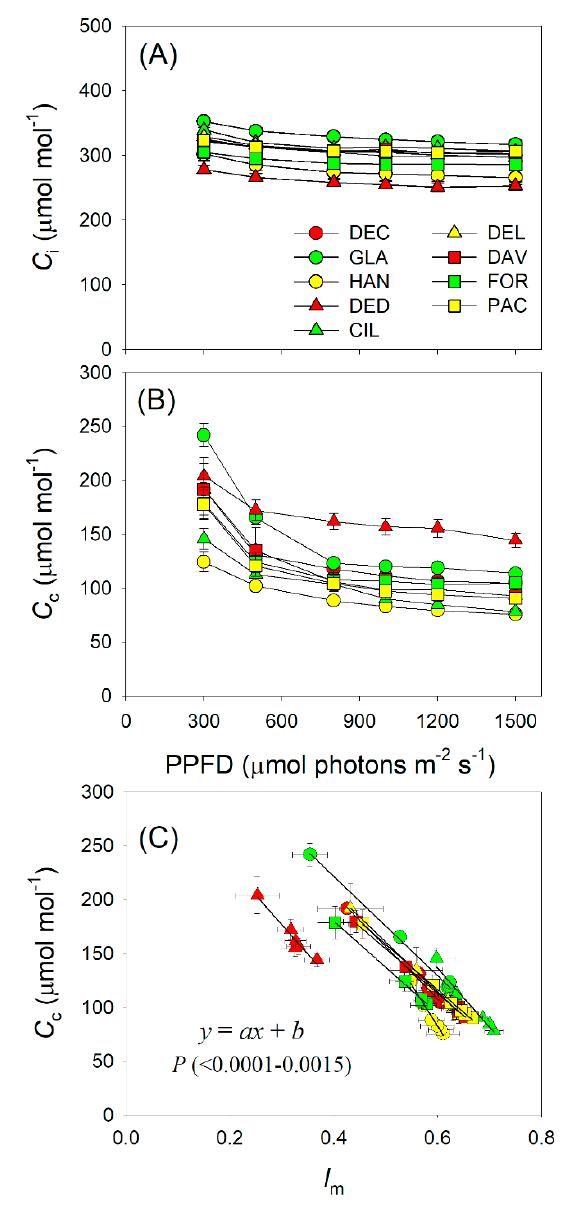
Figure 5. ( A , B ) Responses of intercellular and chloroplast CO 2 concentrations ( C i and C c , respectively) to incident light intensity in nine Rhododendron species. ( C ) Relationship between l m and C c across light response curves in these nine Rhododendron species. Symbols represent means ± SE ( n = 4–5). Species abbreviations: DEC, R. decorum ; GLA, R. glanduliferum ; HAN, R. hancockii ; DED, R. decorum subsp. disprepes ; CIL, R. ciliicalyx ; DEL, R. delavayi ; DAV, R. davidii ; FOR, R. fortunei ; PAC, R. pachypodum . − 2 − 1 At 1500 µ mol photons m s , C trans was calculated to analyze the rate-limiting step of A N . The operating C c values are significantly lower than the C trans values in these studied species, except for R. decorum subsp. diaprepes (Figure 7). Therefore, the saturating A N at current atmospheric CO 2 concentration was mainly limited by RuBP carboxylation in these Rhododendron species. In R. decorum subsp. diaprepes , A N was limited by RuBP carboxylation and